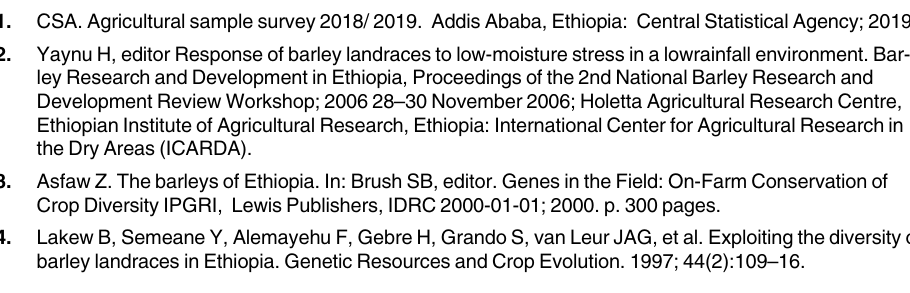
S2 Table. First-generation migrants from genetically distinct clusters. S3 Table. Pairwise correlation matrix for genetic differentiation (PhiPT). S4 Table. Molecular variance (AMOVA) for the Ethiopian barley accessions based on the 14 defined agro-ecological zones; genetic differentiation (PhiPT) of the total